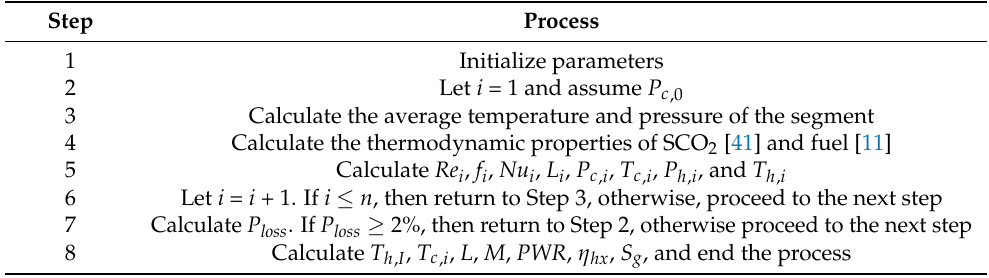
Table 2. Scheme process of the SEG